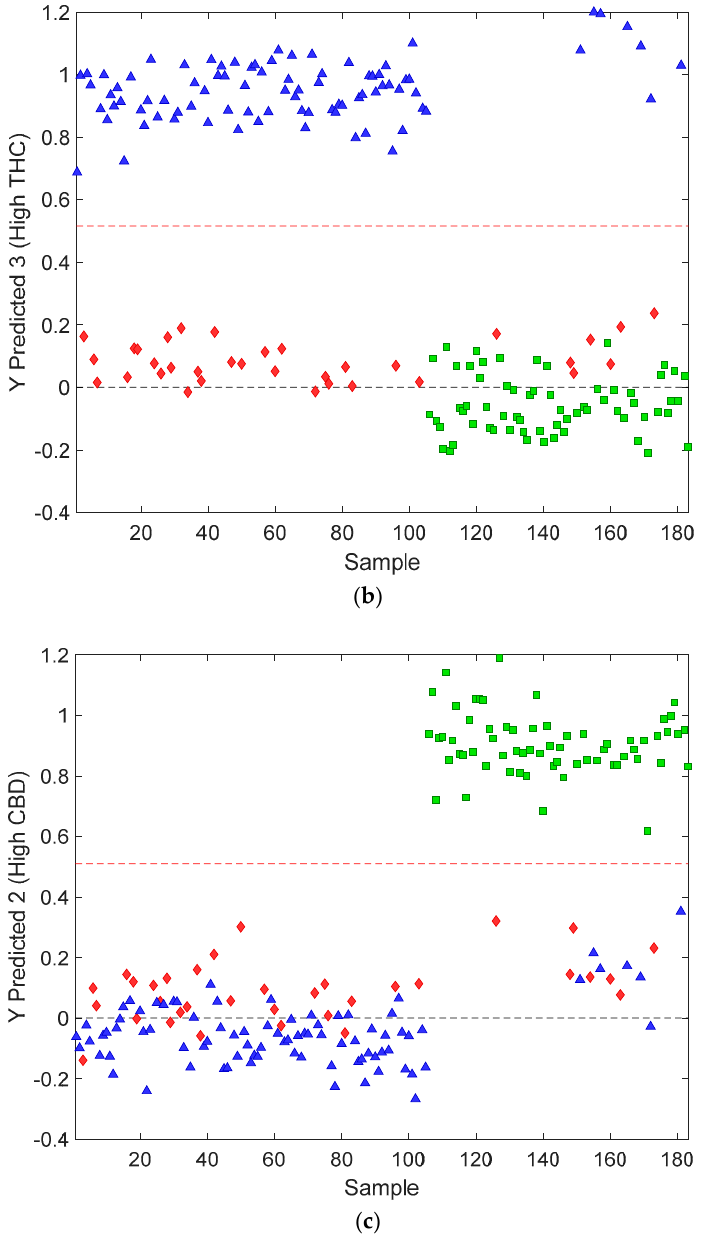
Figure 2 . The classification of ( a ) even-ratio; ( b ) high-CBDA; and ( c ) high-THCA classes using data obtained from the Bruker MPA II instrument. obtained from the Bruker MPA II